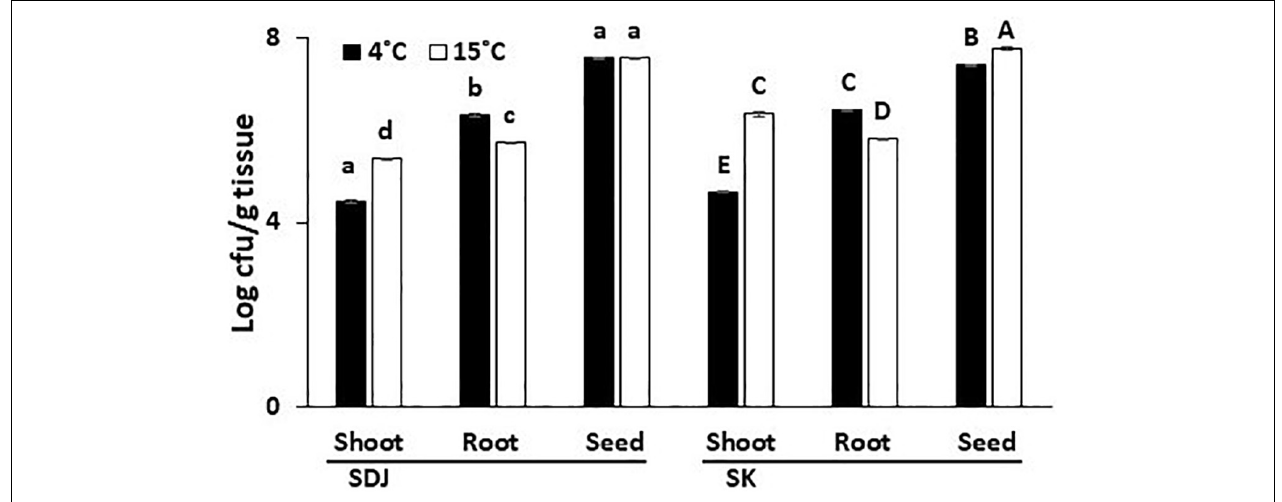
FIGURE 3 | Total culturable bacteria in shoots, roots, and seed remains of rice plant seedlings. The rice seeds, Shindongjin (SDJ) and Sukwang (SK), stored for 6 months at 4 and 15 ◦ C were surface-sterilized and germinated on the moist filter paper. After 10 days of germination, bacteria were isolated in 1/10 TSA media amended with 1% RSE. Data represent mean ± SD and bars with the same letter do not differ significantly at P = 0.05 for each